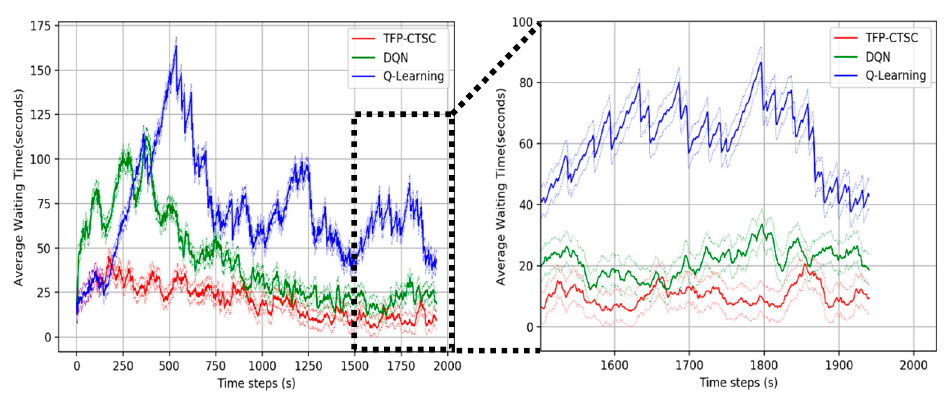
Figure 7. Performance comparison for average waiting time.